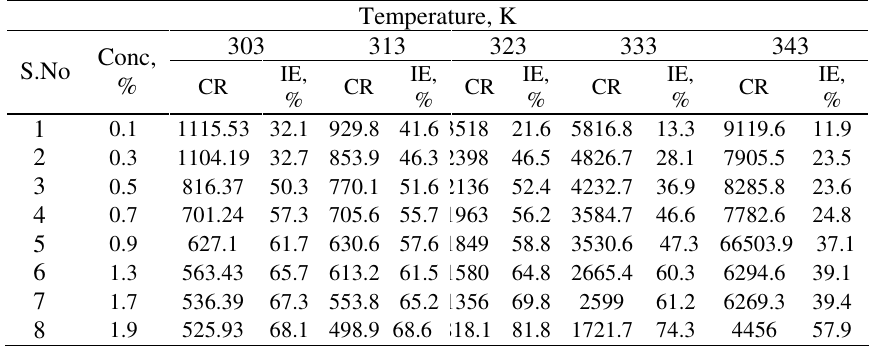
Table 2. Variation of PGA at different